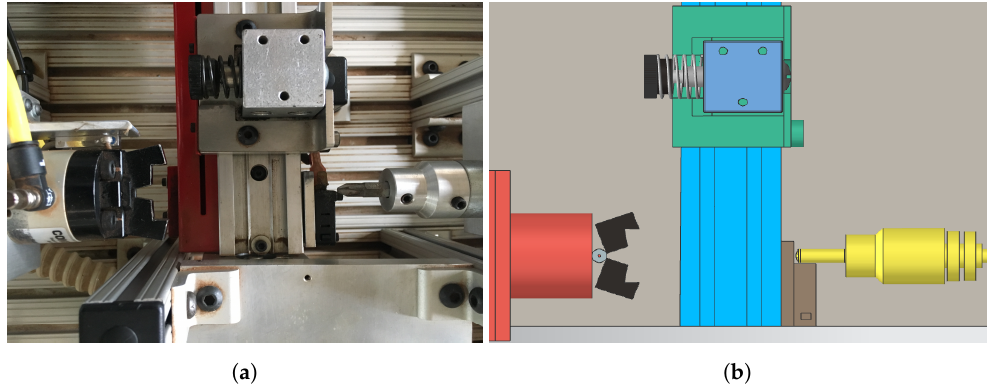
Figure 15. ( a ) machine, body in transit to EOT; ( b ) virtual model, body in transit to